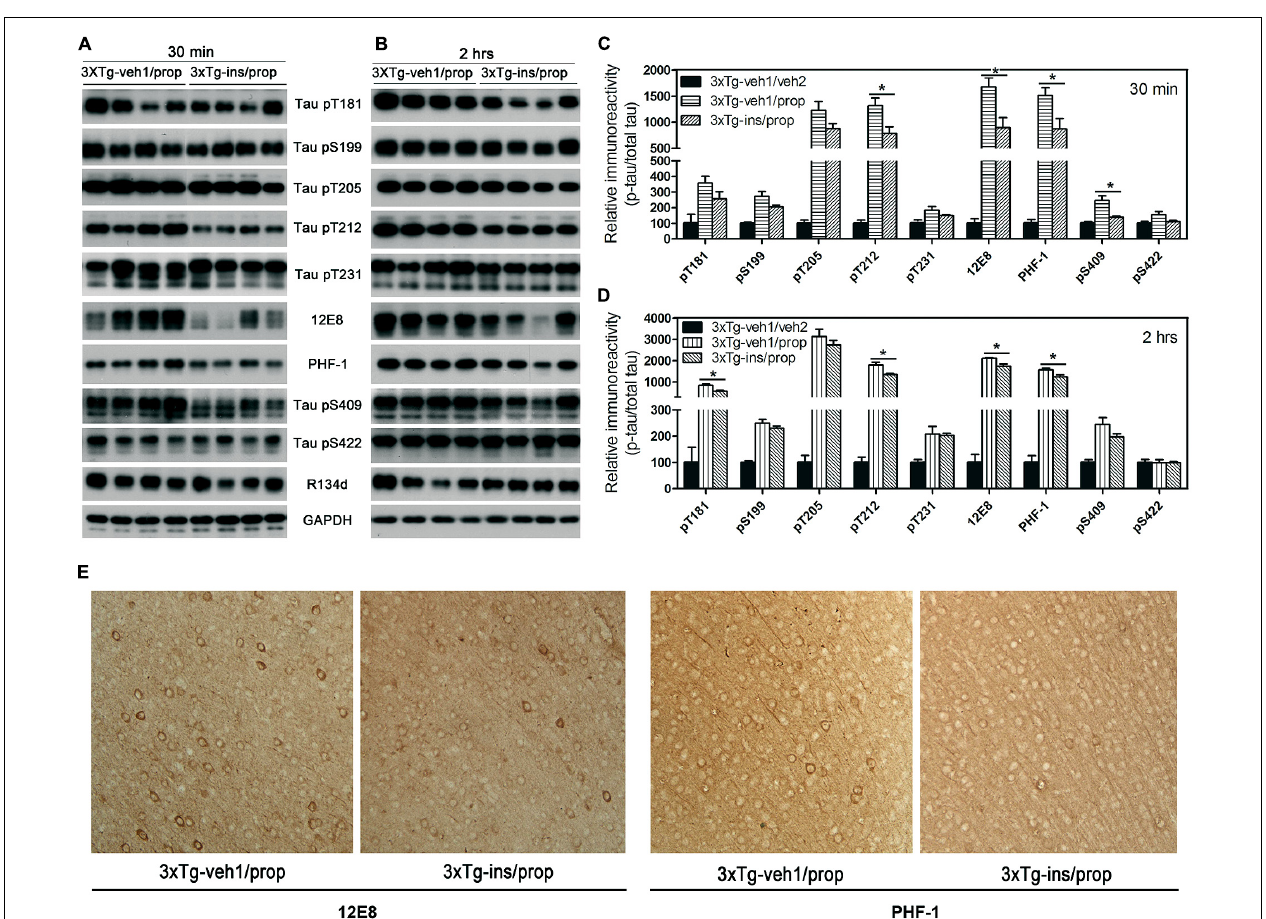
FIGURE 4 | Effect of intranasal insulin treatments on propofol-induced tau phosphorylation. (A,B) Homogenates of the rostral halves of brains from 3xTg-veh1/prop and 3xTg-ins/prop mice sacrificed 30 min (A) or 2 h (B) following intraperitoneal injection of propofol were analyzed byWestern blots developed with antibody R134d against total tau and several phosphorylation-dependent and site-specific tau antibodies, as indicated.